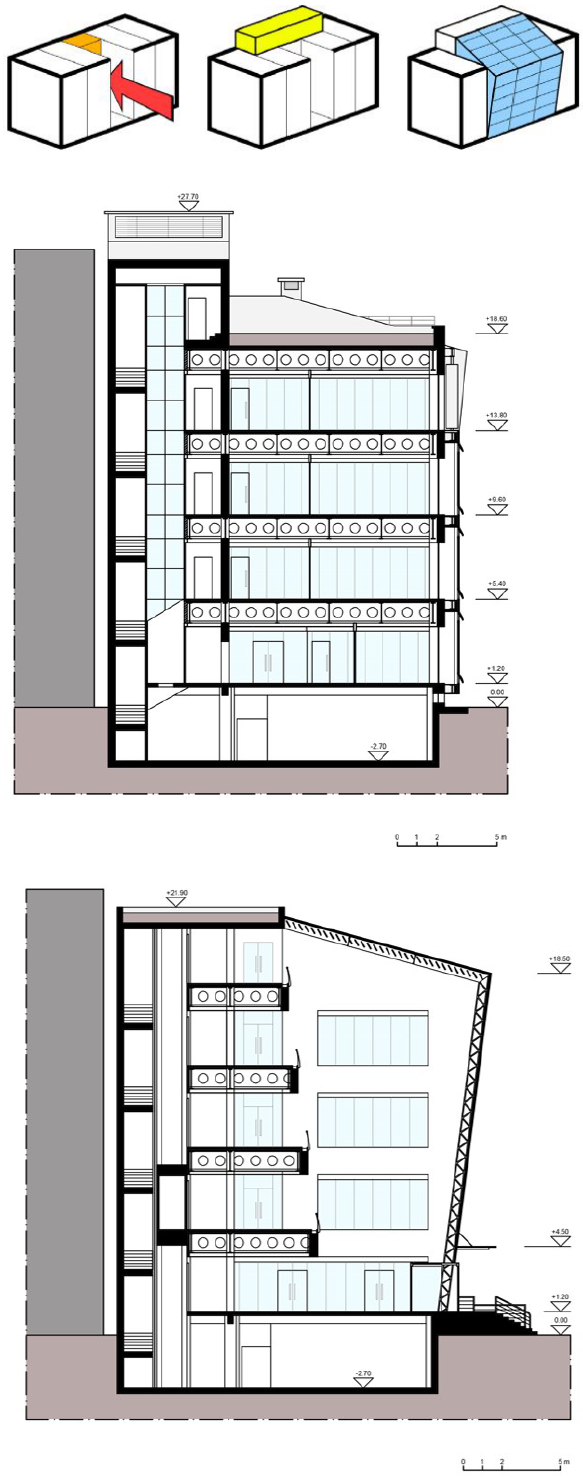
Figure 10: Concept and sections of the building before (left) and after (right) the refurbishment proposal.